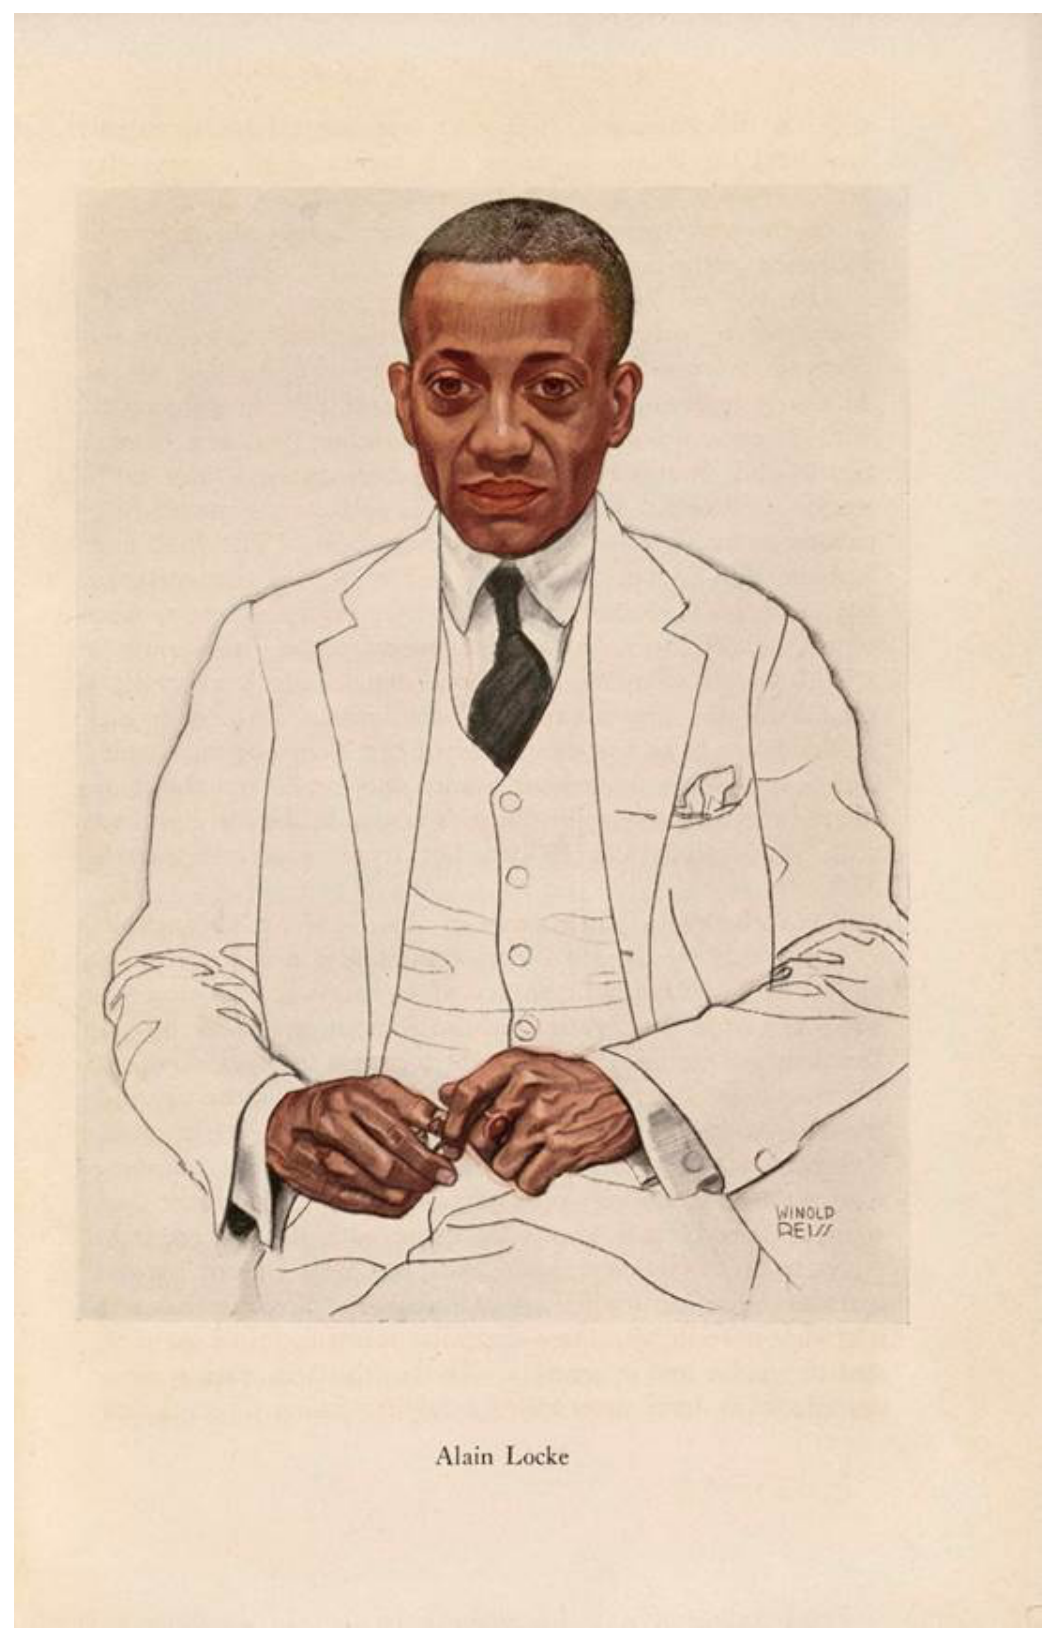
Figure 6 Winold Reiss, ‘Portrait sketch: Alain Locke’, The New Negro: An Interpretation (1925), facing page 6 (Courtesy: National Portrait Gallery, Smithsonian